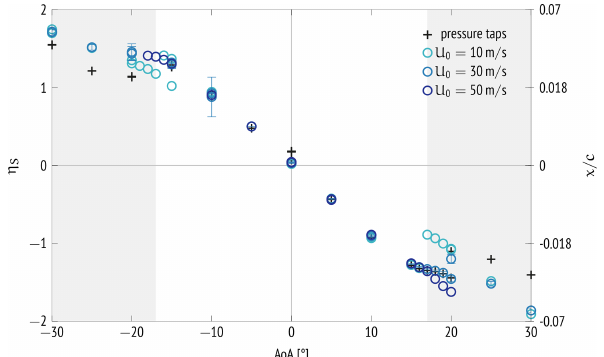
Figure 11. Position of the stagnation point for different angles of attack (AoAs) at different wind speeds on a NACA0018 based on five differential pressure measurements at the leading edge (circles) and by finding the maximum of pressure using 40 flush-mounted pressure taps at 30ms − 1 (crosses). Shaded areas show the stall re- gion of the airfoil.